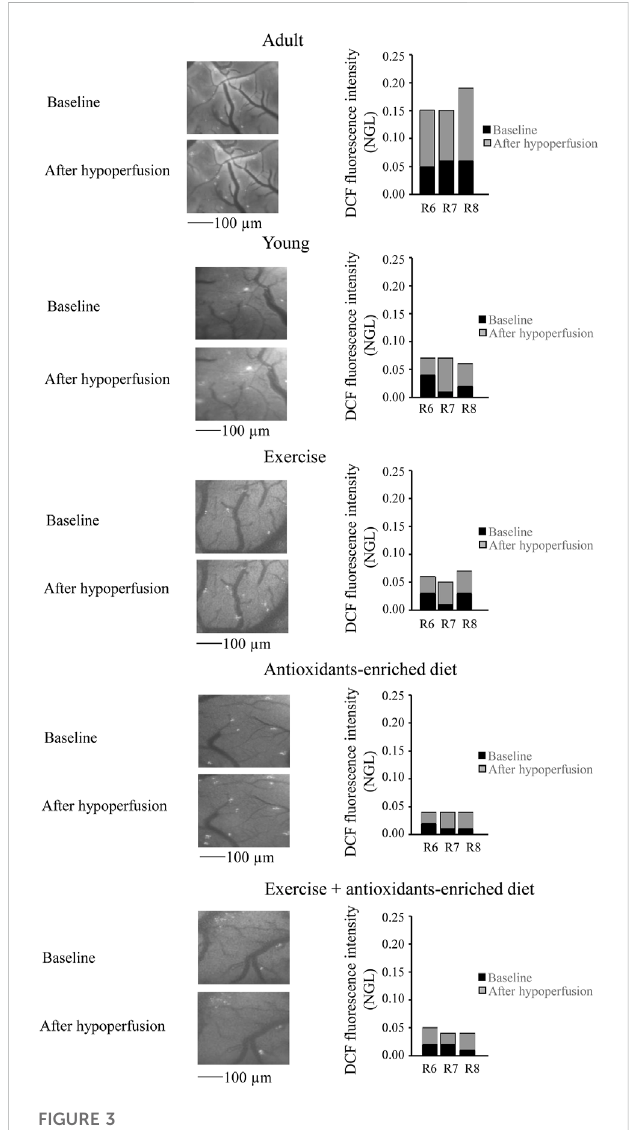
FIGURE 3 Reactive oxygen species (ROS) formation was evaluated in vivo by DCF fl uorescence intensity measured by normalized gray levels (NGLs) inbaselineconditions( n =3),after30 minofhypoperfusion( n =3).Right reports the graphs showing the variations in each animal of each experimental group (R6 – R8). Left reports the corresponding video images of the pial microcirculation obtained with a fl uorescence microscope in a SHR rat belonging to each experimental group. reperfusion caused a marked increase in microvascular permeability (NGL = 1.23 ± .03, p < .01 vs. baseline) (Figure 2). Young SHRs showed a slight microvascular leakage (NGL = .04 ± .02, p < .01 vs. A group) under baseline conditions and at the end of BCCAO, presented an increase in leakage (NGL: .10 ± .02 ( p < .01 vs. baseline), more pronounced at the end of the reperfusion (NGL: .26 ± .03, p < .01 vs. baseline and A group) (Figure 2). Exercising SHRs (E group) showed slight fl uorescent leakage (NGL: .05 ± .01, p < .01 vs. A group) during baseline conditions. At the end of hypoperfusion, the fl uorescent leakage was .08 ± .02 NGL ( p < .01 vs. baseline), but the microvascular permeability increased at the end of reperfusion (NGL: .54 ± .02, p < .01 vs. baseline, A and Y groups) (Figure 2).